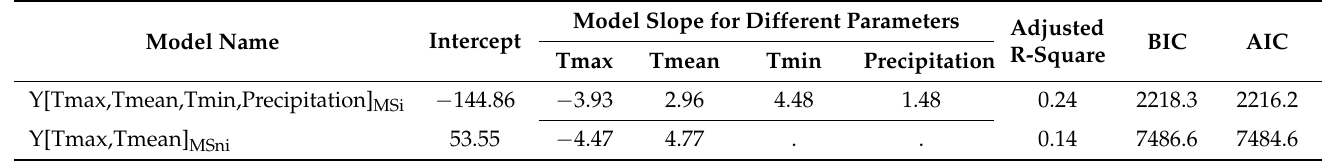
Table 3. The results of the best multilinear models from the time series of 1980–2019 for the irrigated and non-irrigated zones in